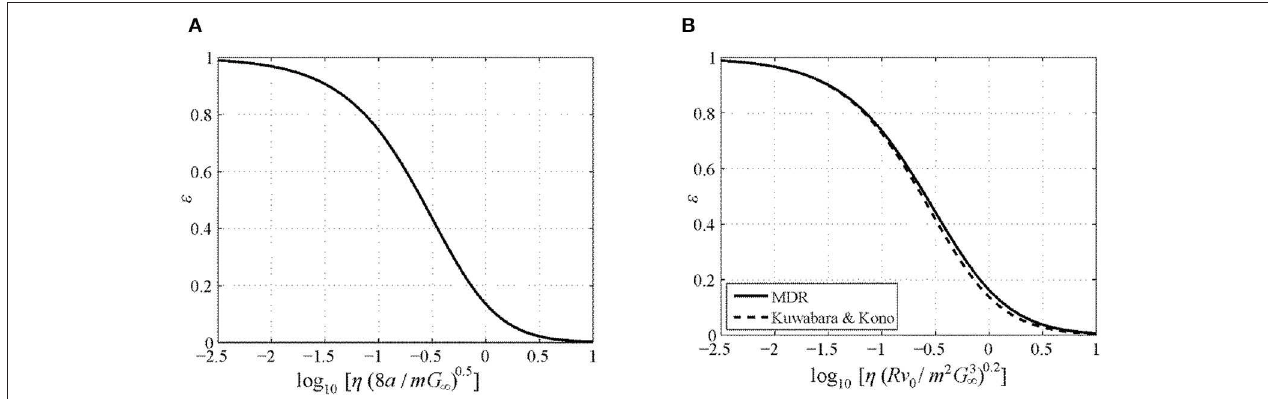
FIGURE 1 | Coefficient of restitution as a function of the governing damping parameter for the impact onto an incompressible Kelvin solid. (A) Impact of a cylindrical flat punch. (B) Impact of a paraboloid; solid line, contact mechanically rigorous model implemented within the method of dimensionality reduction (MDR); dashed line, Kuwabara–Kono